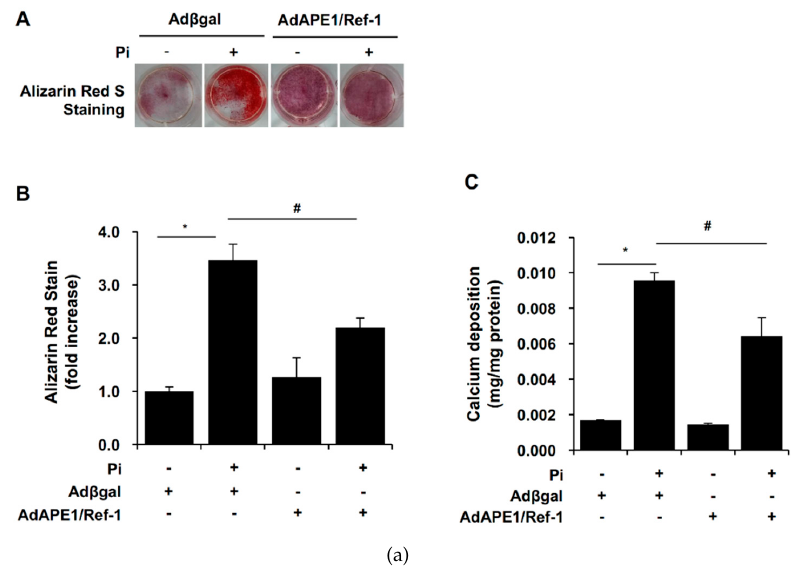
Figure 1. Inorganic phosphate (Pi) inhibited apurinic/apyrimidinic endonuclease 1/redox factor-1 (APE1/Ref-1) transcription and protein expression in vascular smooth muscle cells (VSMCs). ( A , B ) Changes in endogenous APE1/Ref-1 expression during cell exposure to Pi (5 mM) for the indicated times (0–6 days). Expression of APE1/Ref-1 and β -actin was measured by Western blot. Typical representative data ( A ) and summarized data ( B ) are shown. Each bar represents the mean ± standard error of the mean (SEM) fold increase relative to basal APE1/Ref-1 expression ( n = 5). * p < 0.05 vs. control by one-way analysis of variance (ANOVA). ( C ) Effect of Pi (5 mM) on APE1/Ref-1-promoter luciferase activity in primary VSMCs. Firefly luciferase activities were normalized to those of the co-transfected Renilla luciferase. Cells were treated with Pi (5 mM) for 4 days. Each bar represents the mean ± SEM as a percentage of basal APE1/Ref-1-promoter luciferase activity ( n = 6). * p < 0.05 vs. control by one-way ANOVA.